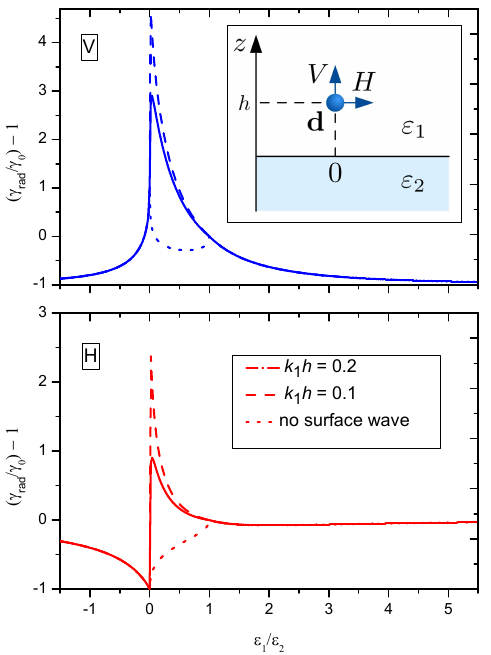
Figure 6. Dependence of the radiative decay rate, γ , on the dielectric constant ratio ε 1 / ε 2 for two two different distances to the interface between them, k 1 h = 0.1 and 0.2. The dotted shows the dependence when the contribution of evanescent waves (that exists for 0 < ε 1 / ε 2 < 1) is neglected; it is independent of h . The inset shows two orthogonal orientations of the dipole moment. The upper plot is for the vertical dipole and the lower for the horizontal